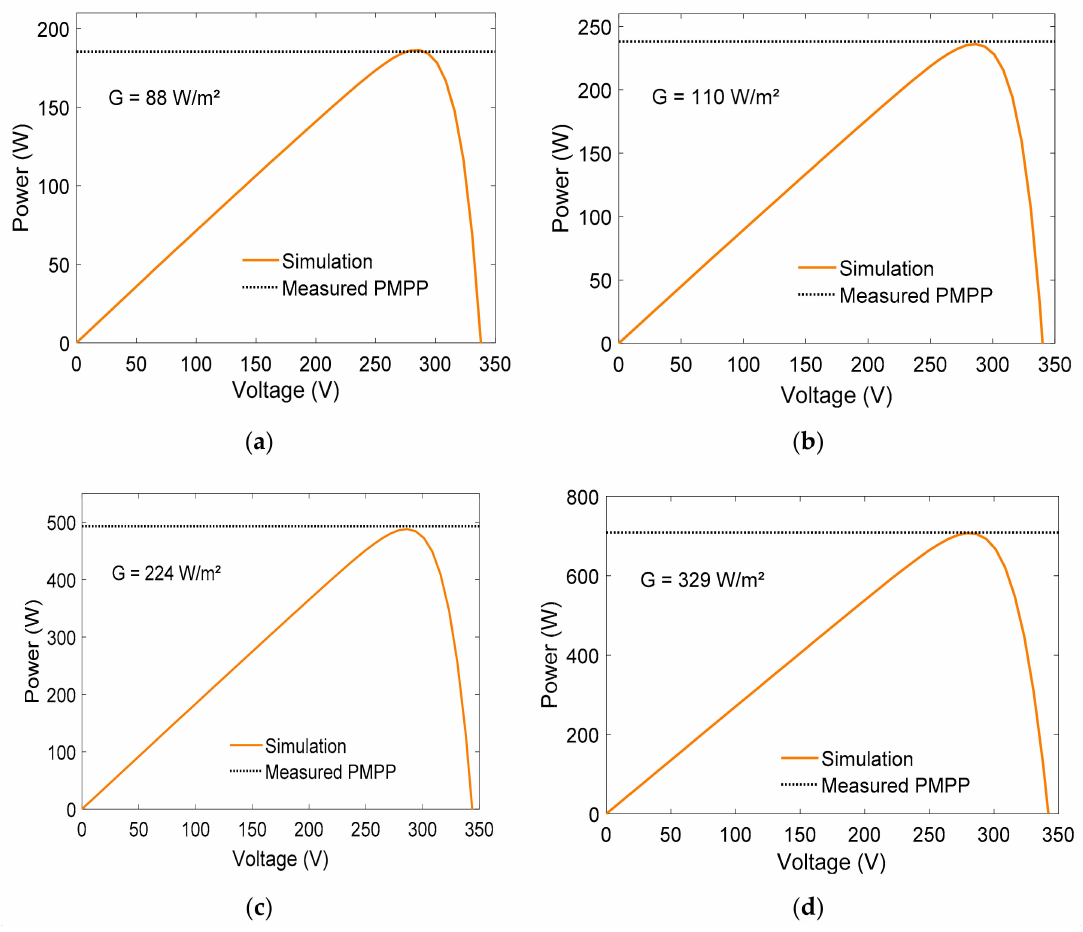
Figure 4. Power vs. voltage (P–V) curves for System 1 ( a ) G = 88 W / m 2 , ( b ) G = 110 W / m 2 , ( c ) G = 224 W / m 2 , and ( d ) G = 329 W / m 2 .